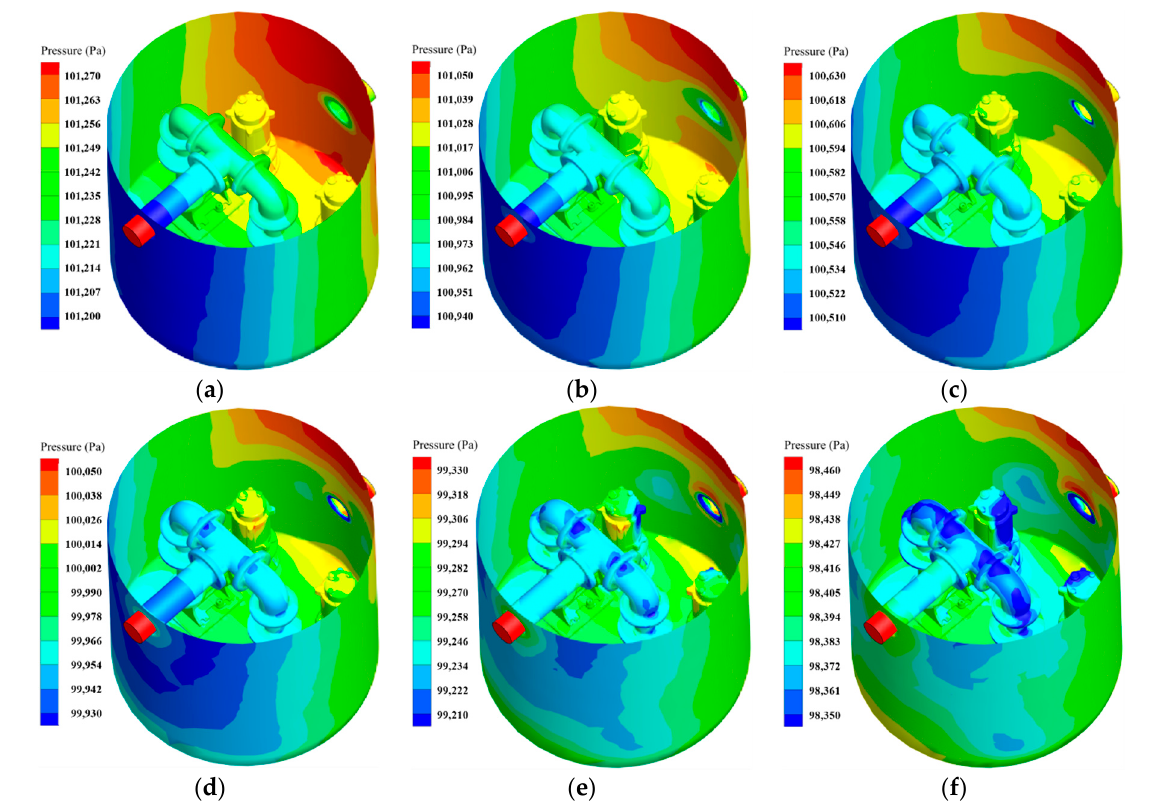
Figure 11. Prefabricated pumping station wall pressure distribution diagram. ( a ) 0.33 Q d , ( b ) 0.67 Q d , ( c ) 1.00 Q d , ( d ) 1.33 Q d , ( e ) 1.67 Q d , and ( f ) 2.00 Q d .